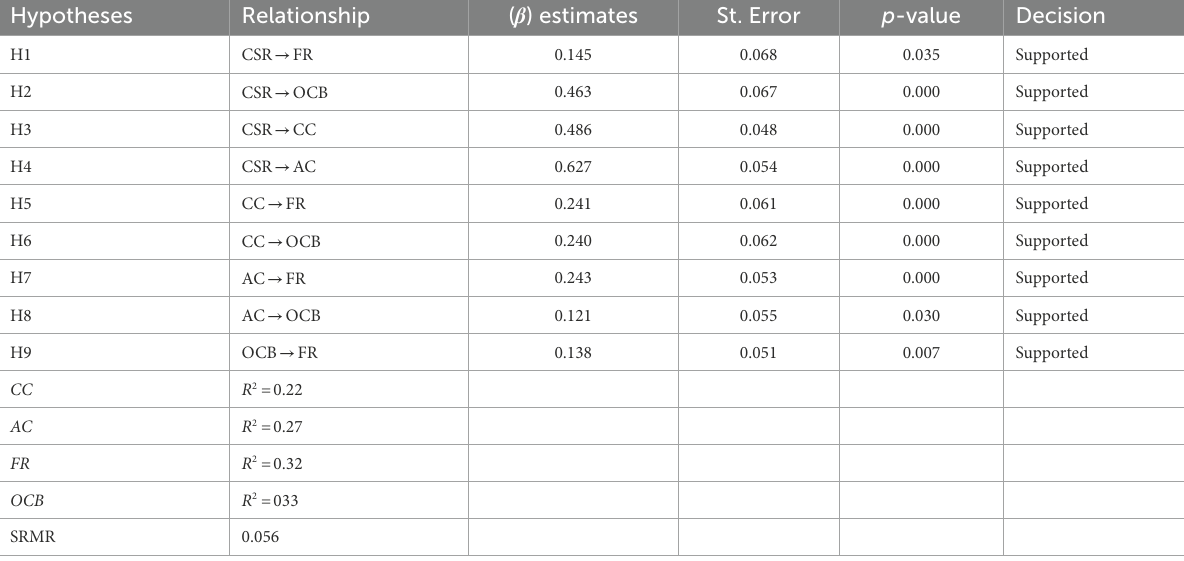
TABLE 5 Results of the path coefficient of the structural model (direct